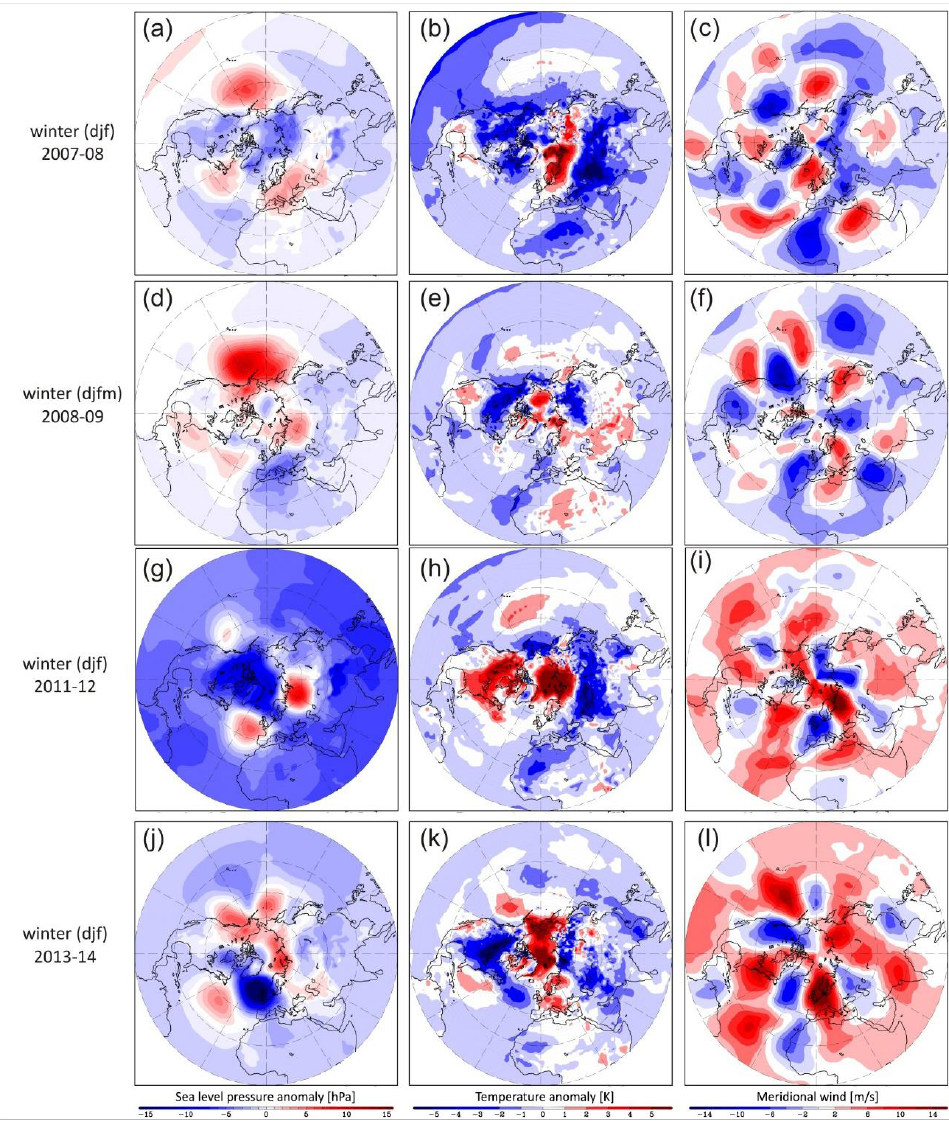
Figure 10. Northern hemisphere sea level pressure anomalies, temperature anomalies and stationary Rossby wave pattern. ( a , d , g , j ) Sea level pressure anomalies (from 1981 to 2010 climatology; 15 day mean, centered on January 2008, 2009, 2012 and 2014, respectively); ( b , e , h , k ) as ( a , d , g , j ) but for surface temperature anomaly (K), while ( c , f , i , l ) as the previous ones but for meridional (ms − 1 ) in the upper troposphere (300 hPa) based on NCEP/NCAR data (Kalnay et al., 1996). Winters 2008-09 (DJFM) is based on longer period representative of most intense snow precipitation. See colored bars for anomaly quantification where red and blue colors mean positive and negative anomaly